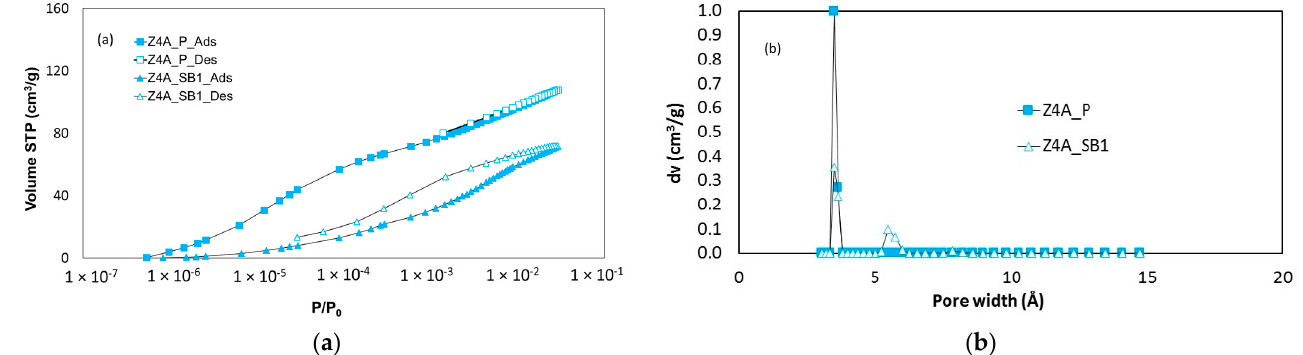
Figure 5. ( a ) CO 2 adsorption–desorption isotherms at 273 K on 4A zeolite samples, and ( b ) Pore Size Distribution obtained with a NLDFT model. Adsorption and desorption branches are represented with different symbols in the case of the spherical beads of 4A zeolite to highlight the surprising irreversibility of the isotherm.